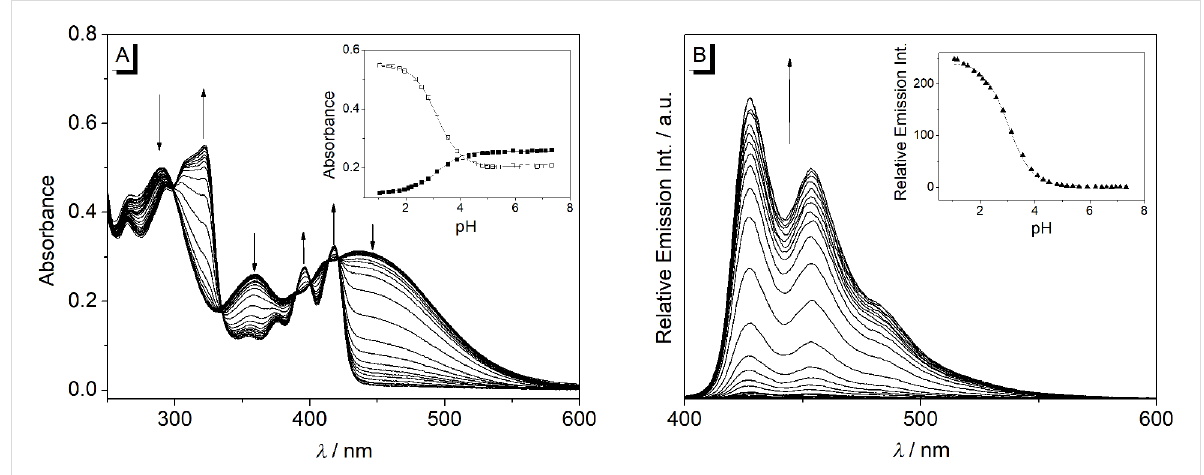
Figure 5: Photometric (A) and fluorimetric (B) acid-base titration of 2c ; c = 20 μ M in Britton–Robinson buffer; λ ex = 375 nm. Arrows indicate the development of absorption or emission bands with decreasing pH value. Inset: Plot of the absorption (A) at 360 nm (black rectangle) and 322 nm (white rectangle) and emission (B) at 427 nm (black triangle) versus pH. Lines denote the best fit of experimental data to the theoretical